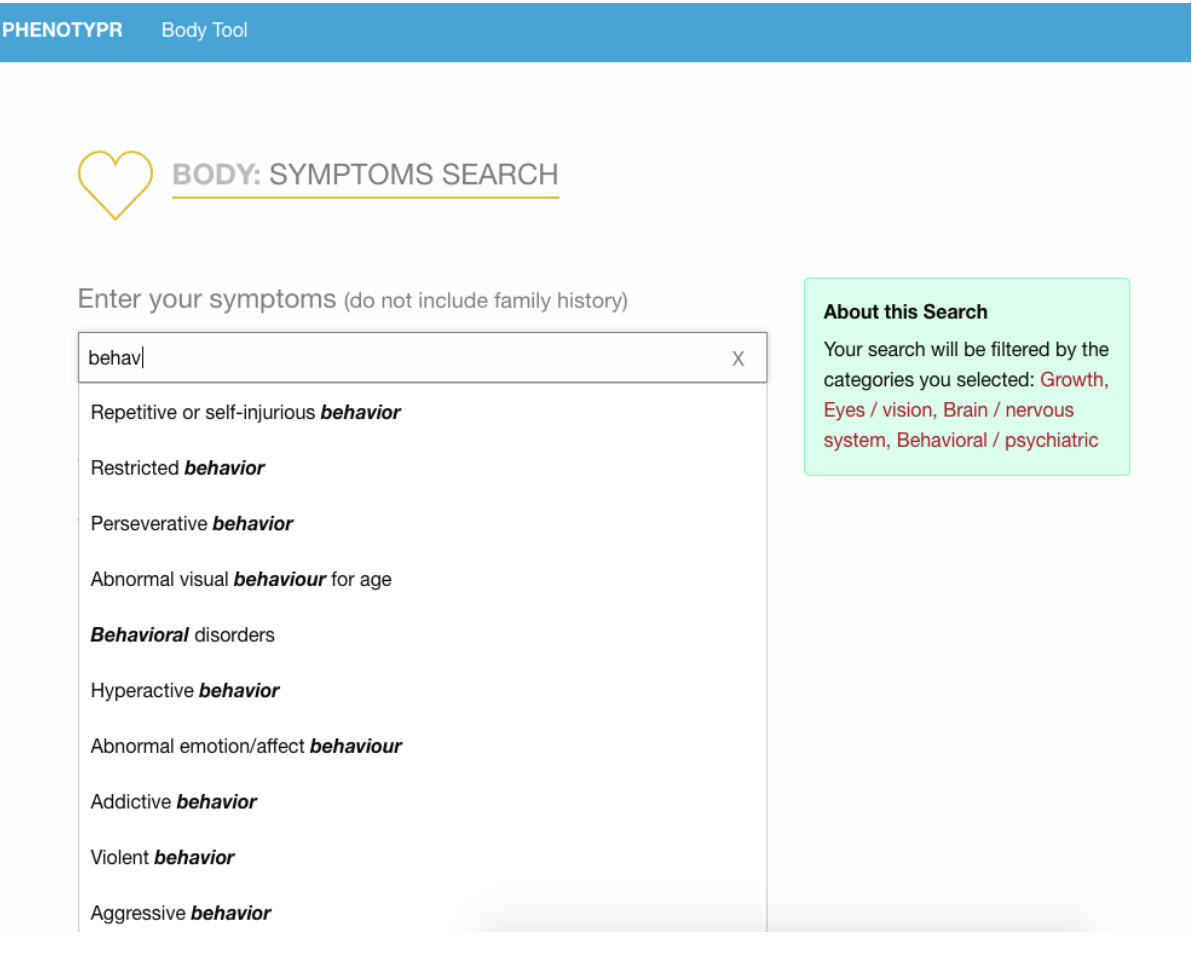
Figure 2. Data entry for Phenotypr: symptom search tool.